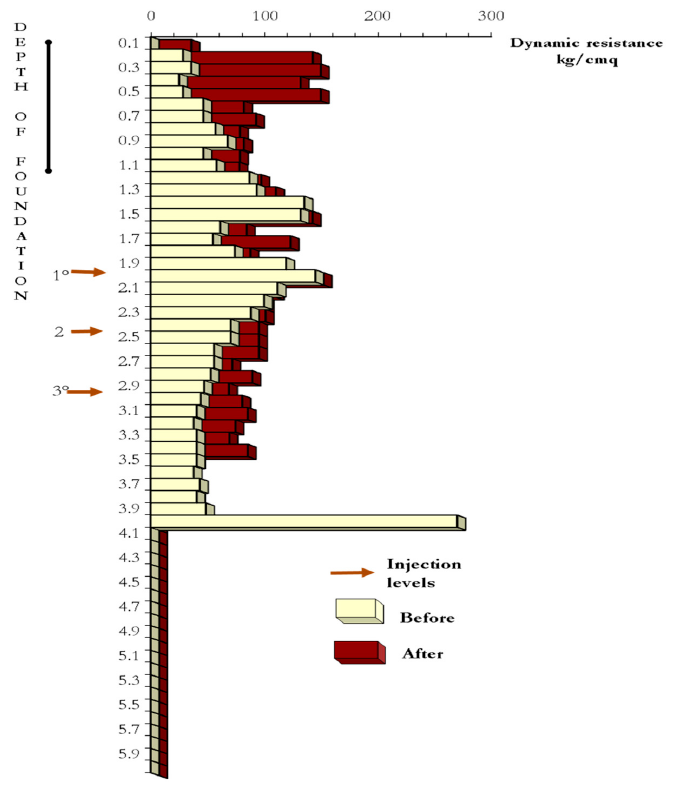
Figure 7. Penetrometric tests performed before and after injection.